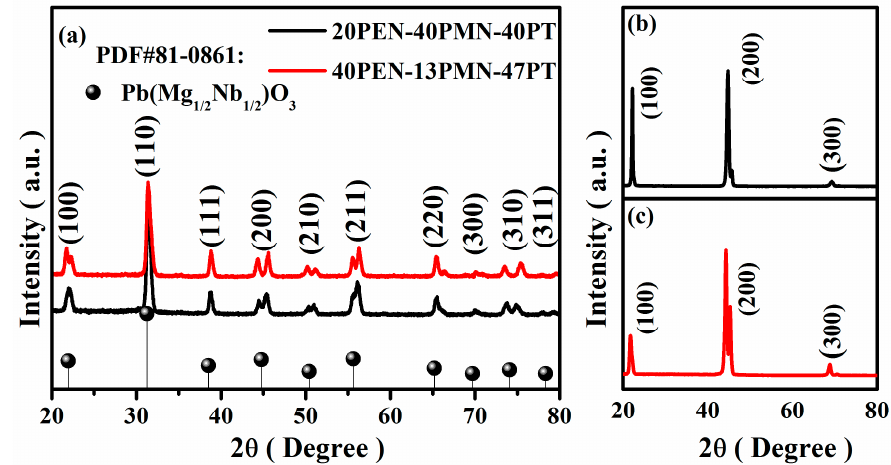
Figure 2. XRD patterns of ( a ) PEN-PMN-PT crystals powders; ( b ) [100]-oriented 20PEN-40PMN-40PT crystals; and ( c ) the [100]-oriented 40PEN-13PMN-47PT crystals.